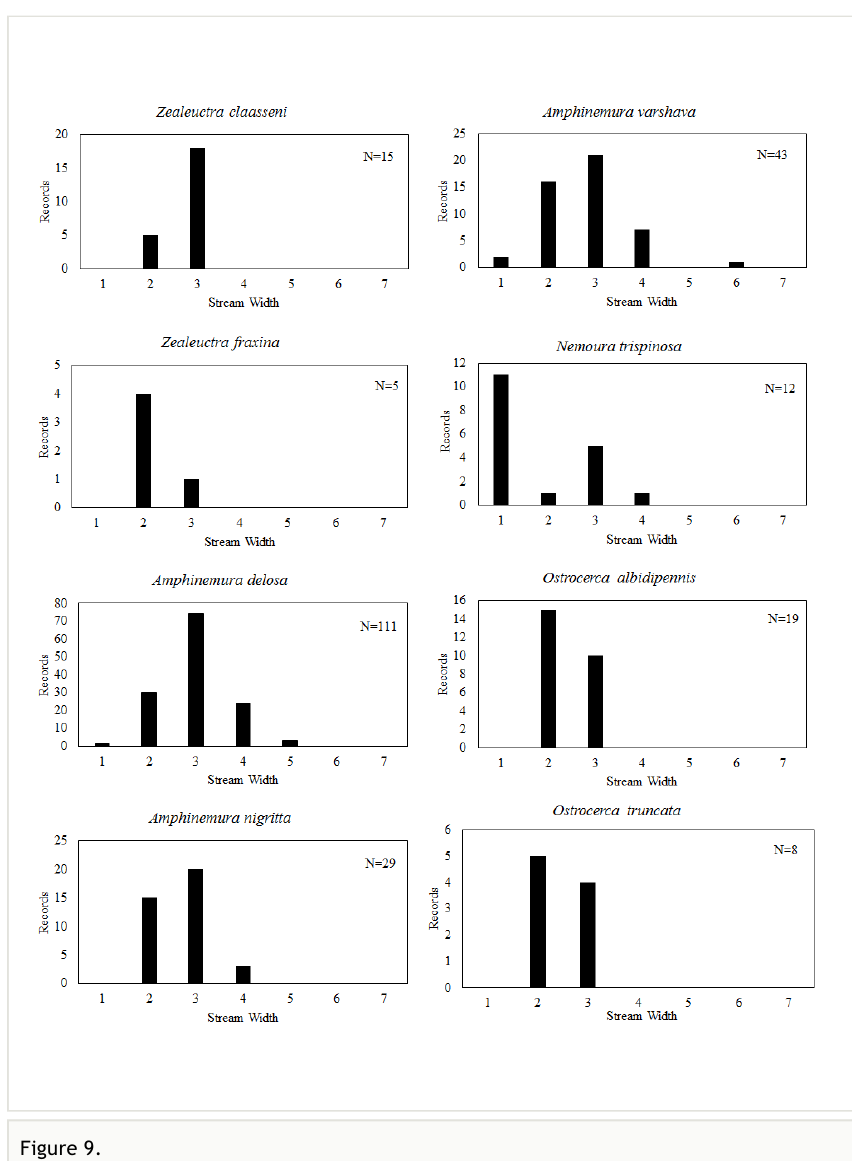
Figure 9. Stream width categories occupied by Leuctridae and Nemouridae species in Ohio. Stream width categories: 1=seep, 2=1-2 m, 3=3-10 m, 4=11=30 m, 5=31-60 m, 6=>60 m, 7=Lake